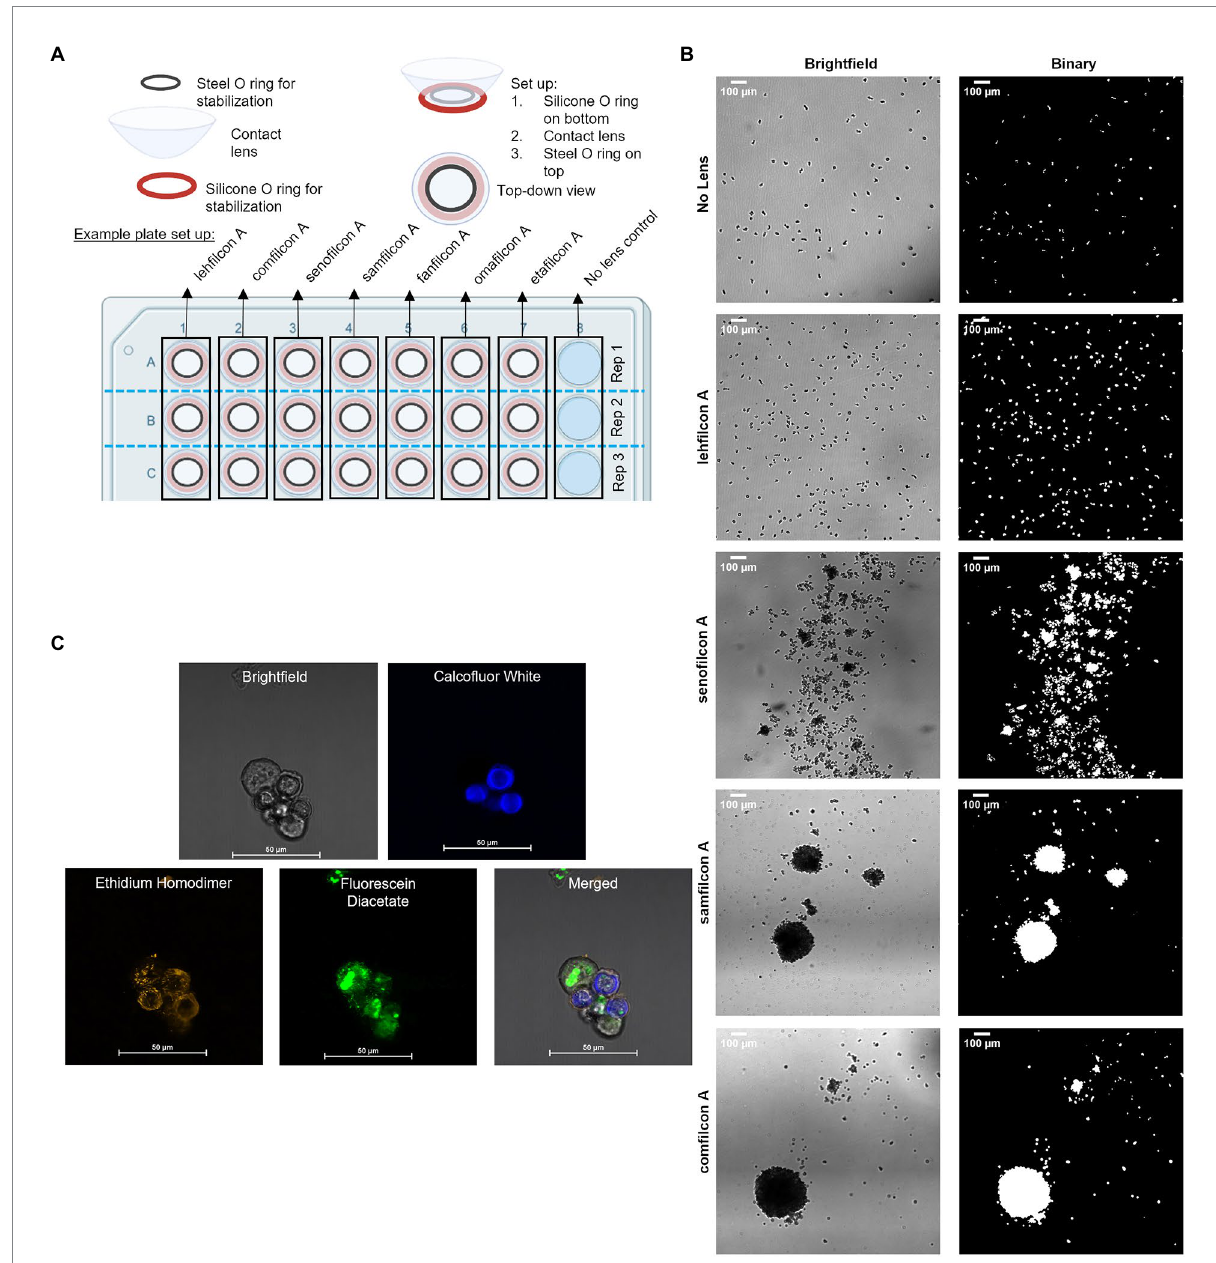
FIGURE 1 Methodological representations. (A) Plate set up for time lapse count and strain analysis of Acanthamoeba aggregation on contact lens materials. (B) Representative large images taken at 4× magnification in brightfield, and then as they appear in binary which is used for count and size analysis (scale bar = 100 μ m). (C) Representative large images of fluorescent confocal microscopy images, taken in brightfield, with three different filters, and merged (please refer to Figure 7 for details; scale bar = 50 μ m) depicting encystment at 6 h using a Biofloat spheroid